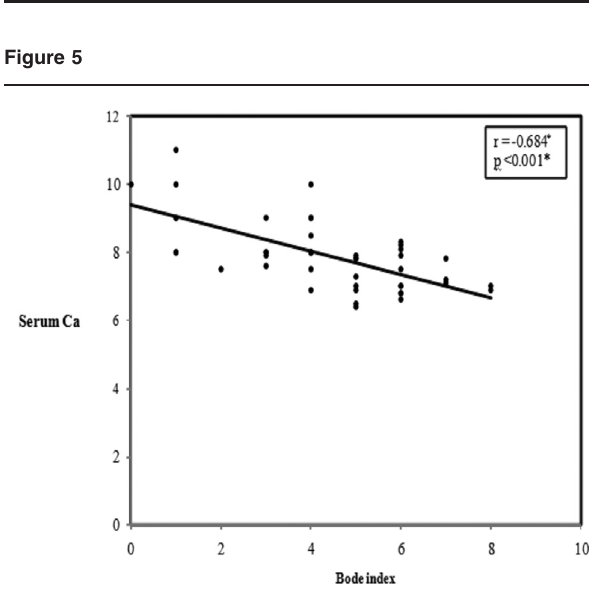
Correlation between BODE index and